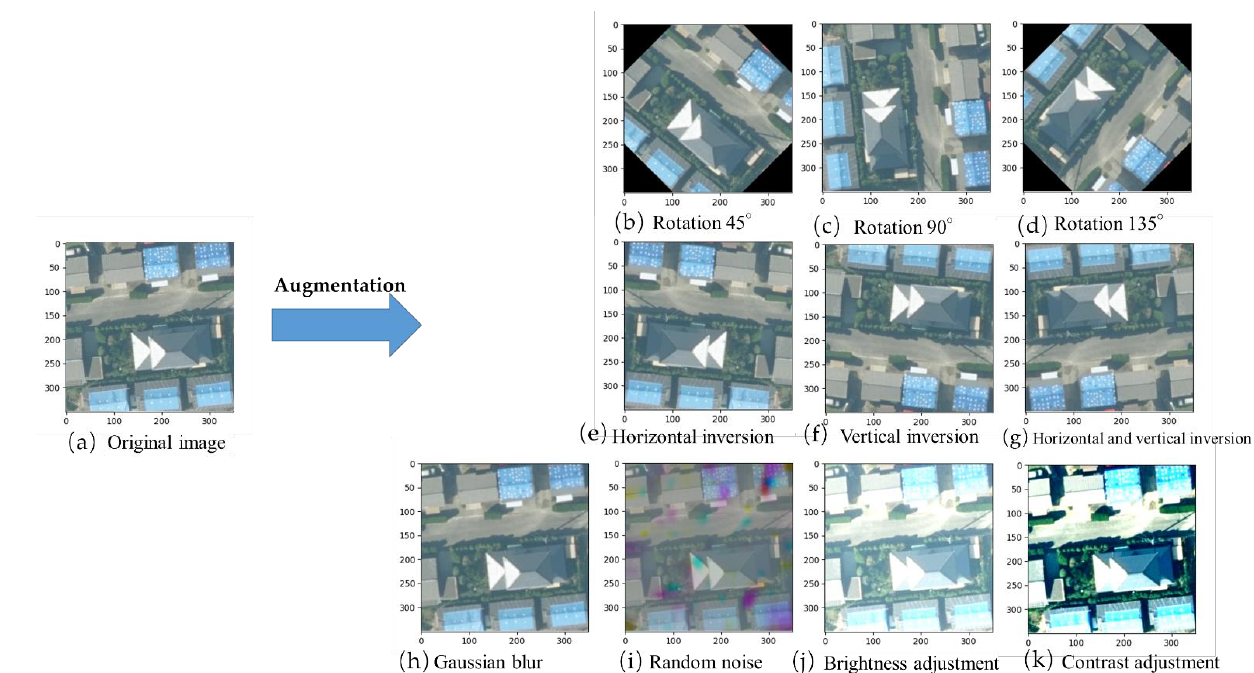
Figure 5. Sample augmentation of a training sample.